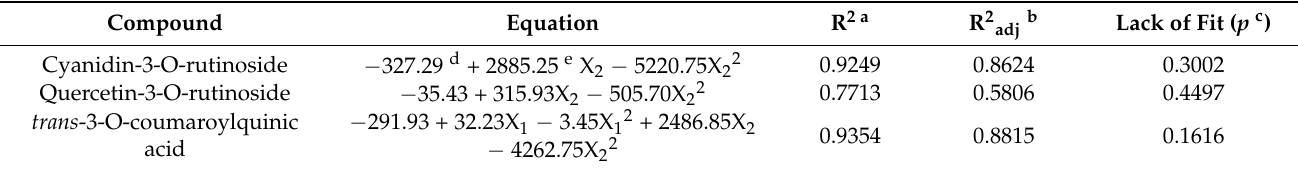
Table 2. Quadratic equations fitting the experimental values of the 3 compounds extracted by UAE from cherries